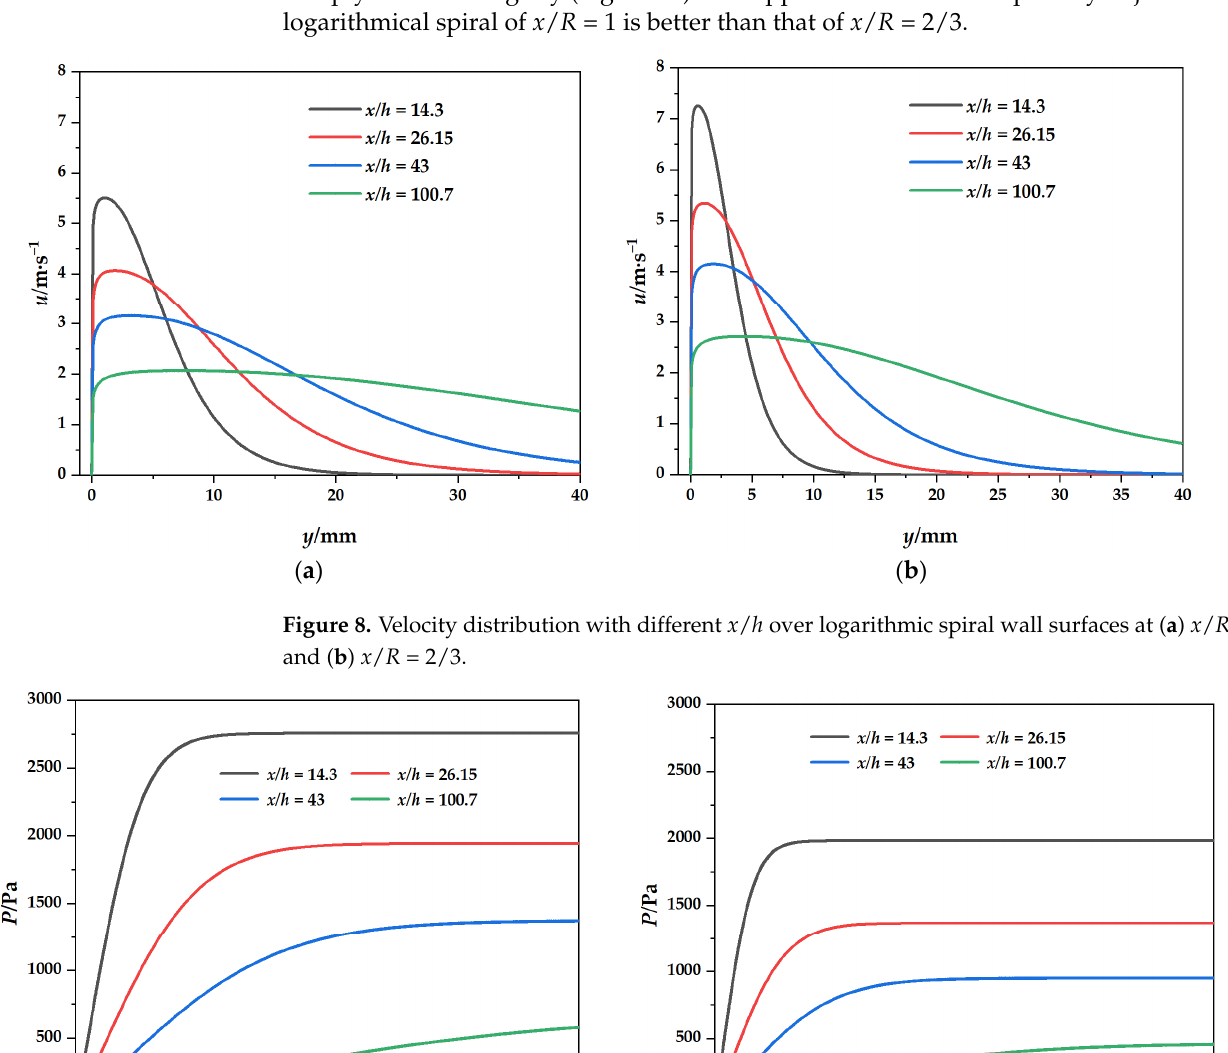
( b ) Figure 7. Lift index with different u i over logarithmic spiral wall surfaces at ( a ) x / R = 1 and ( b ) x / R = 2/3.